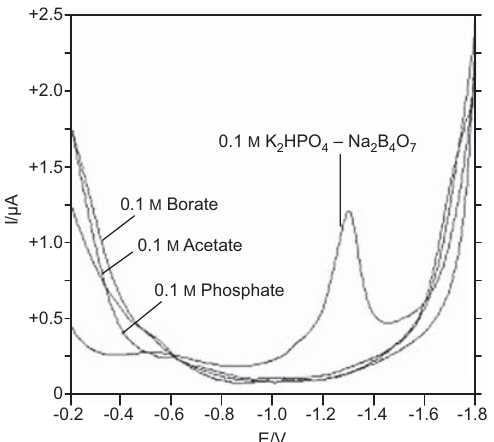
Figure 7 Effect of supporting electrolyte on the peak current of EZE.